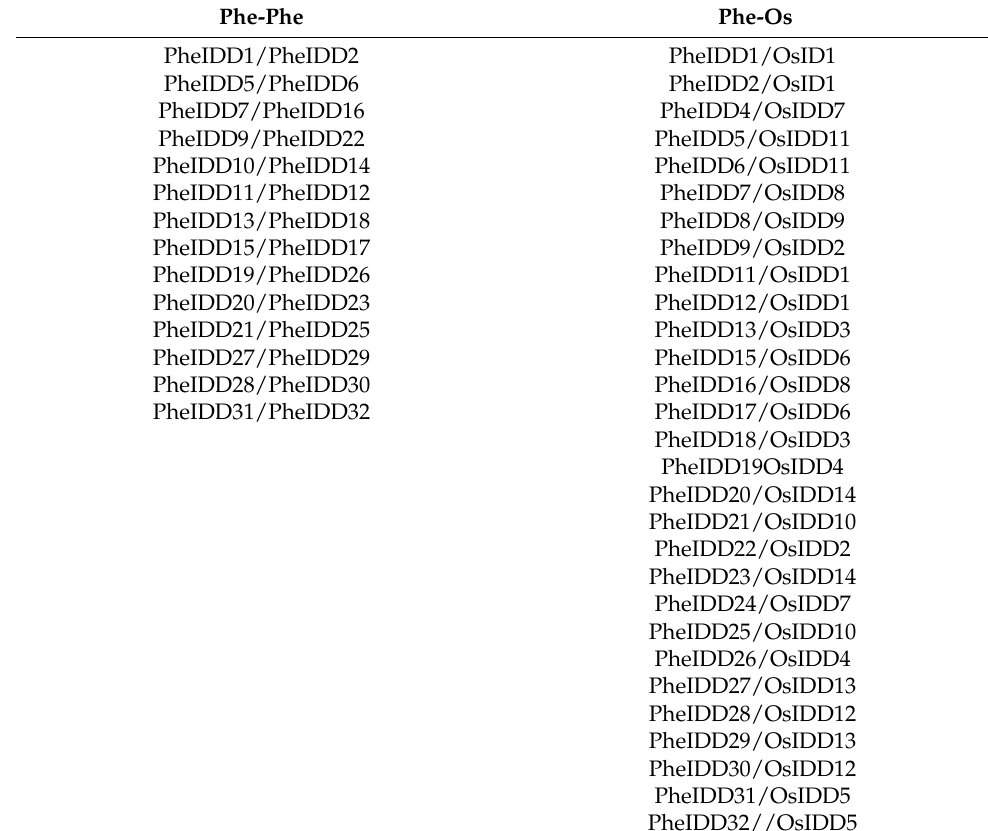
Table 1. Paralogous (Phe-Phe) and orthologous (Phe-Os) IDD gene pairs in moso bamboo and